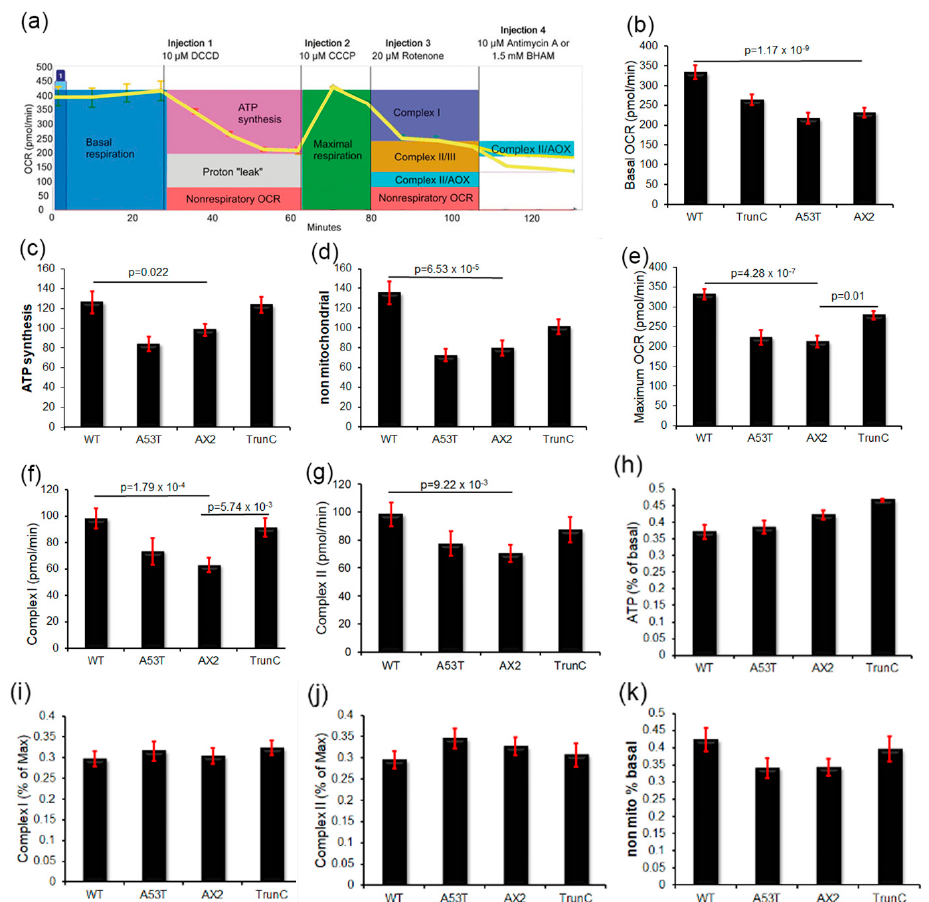
Figure 8. Mitochondrial respiration is not impaired in strains expressing α -synuclein. Panel ( a ): Example of a Seahorse experiment showing the raw OCR values plotted against time. Various pharmacological agents were added sequentially as indicated at the top of the panel DCCD (dicyclohexylcarbodimide, in all wells), CCCP (carbonyl cyanide m-chlorophenyl hydrazone, in all wells), Rotenone (in all wells) and either Antimycin A (in half of the wells) or BHAM (benzohydroxamic acid, in the other half of the wells). Coloured boxes illustrate how each component was measured [45]. Total Complex II activity was determined as the sum of the effects of Antimycin A and BHAM. Panels ( b – g ): Horizontal bars with p values indicate the pairwise comparisons that were statistically significant (at p ≤ 0.05). All other pairwise differences were not statistically significant. The parental strain AX2 and strains expressing different forms of α -synuclein (full length α -synuclein (wt) n = 7, α -synuclein with a point mutation at amino acid 53 (A53T) n = 2 and α -synuclein with a truncation of the C terminal 20 amino acids (TrunC) n = 8) were analysed by Seahorse Respirometry. Each strain was assayed over four replicates in an average of 3-6 independent experiments. Significant differences from the parental strain AX2 are indicated in the p values (t-test). Error bars are standard errors of the mean. Basal OCR ( b ), OCR dedicated to ATP synthesis ( c ), nonmitochondrial OCR ( d ), Maximum OCR Complex I ( f ), and Complex II ( g ). Expression of wild type α -synuclein (WT) resulted in increased mitochondrial respiration and an increase in oxygen consumption by nonmitochondrial processes, while expression of α -synuclein with a point mutation (A53T) had no significant effect on respiration and the C-terminal truncation mutant (TrunC) increased the maximum respiratory capacity of the cells. Panels ( h – j ): Each of the parameters was plotted as a proportion of Basal or Maximum OCR and found to be unchanged, which shows that all respiratory complexes were functionally normal and so made the normal relative contribution to respiration. Shown are the OCR attributable to ATP synthesis as a % of Basal OCR ( h ), the relative contribution of Complex I (%) to the Max OCR ( i ), the relative contribution of Complex II (%) to the Max OCR ( j ) and non-mitochondrial OCR as a % of Basal OCR ( k